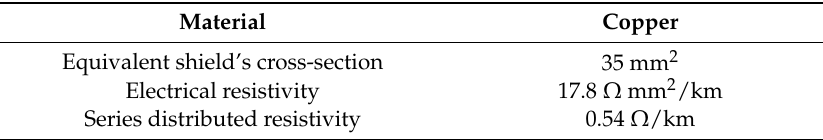
Table 6. Copper rope characteristics.